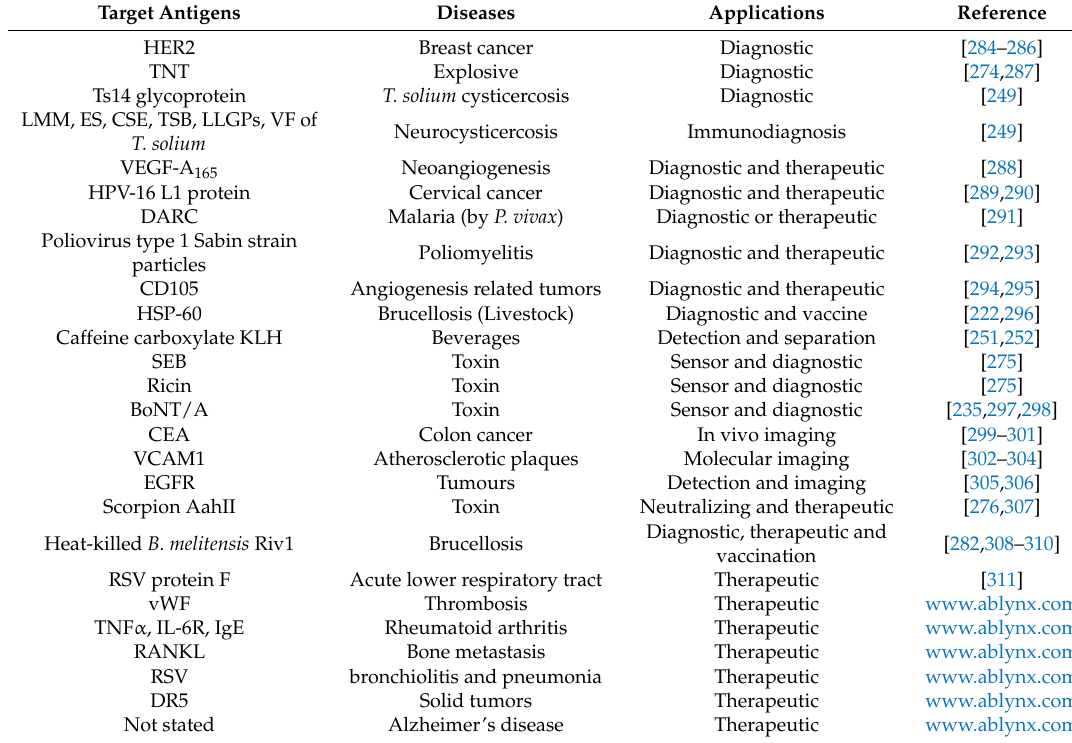
Table 2. The applications of camelids V HH against specified antigens from various